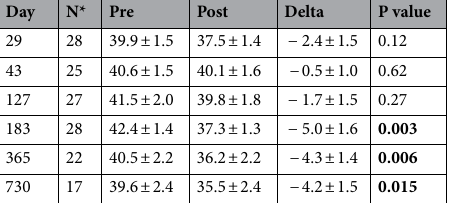
Table 3. Change (delta) in plasma NTproCNP (pmol/L) at 4 h post Vosoritide in relation to duration of therapy. *Number of subjects. Significant values are given in